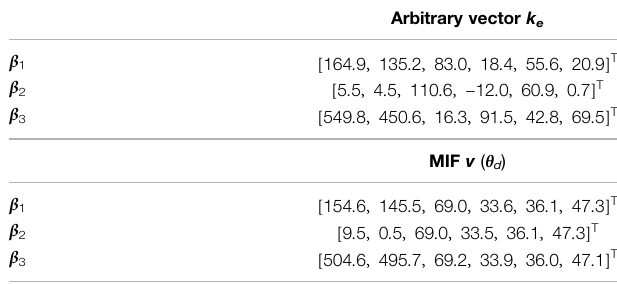
Table 5 lists the arbitrary vectors k e derived from application of Method 1, using the outputs of Eq. 33 ∼ (35); the simulation results are shown in Figure 6 .